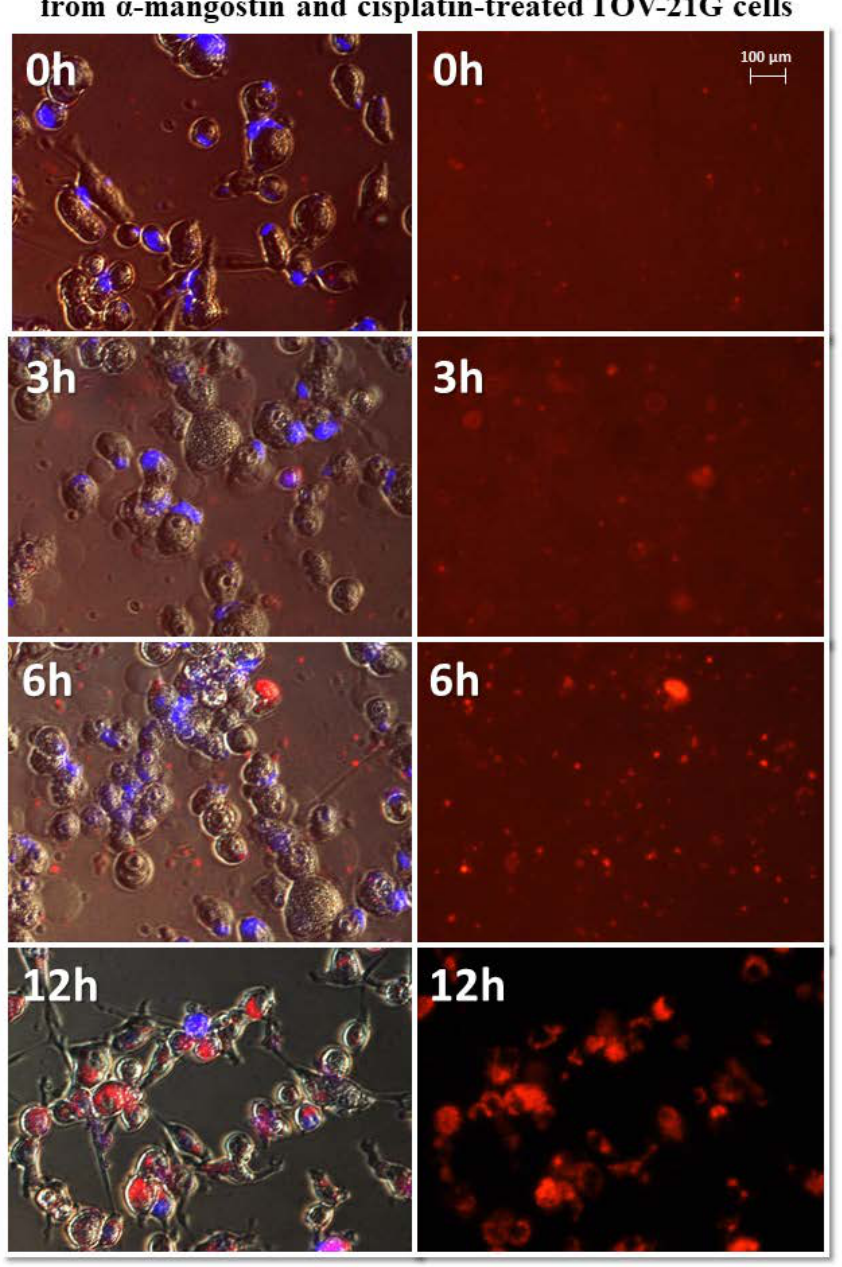
Figure 9. Representative photos of NHDF cells treated with exosomes derived from α -mangostin and cisplatin-treated TOV-21G cells at 0, 3, 6, and 12 h after treatment. Left: merged images of cells in visible light, DAPI stained cells (blue) and Vybrant™ CM-Dil stained exosomes (red), right: Vybrant ™ CM-Dil stained exosomes (red). Nikon Eclipse Ti, magnification